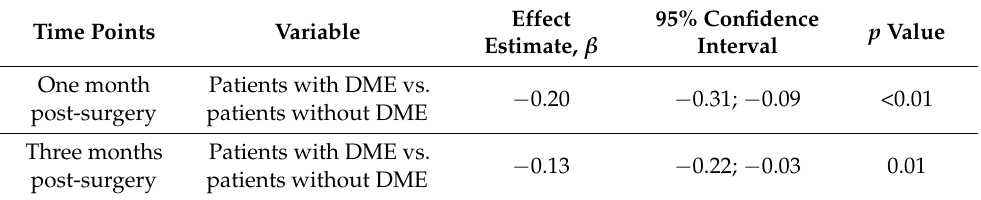
Table 4. Association between DME and the FAZ area in both groups at one and three months